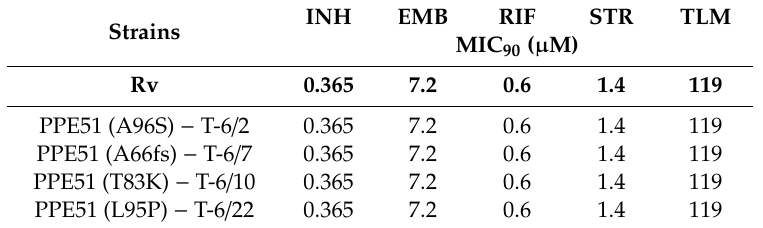
Table 2. The bactericidal e ff ect of selected TB drugs against wild-type Mtb and ppe51 mutants. INH Strains